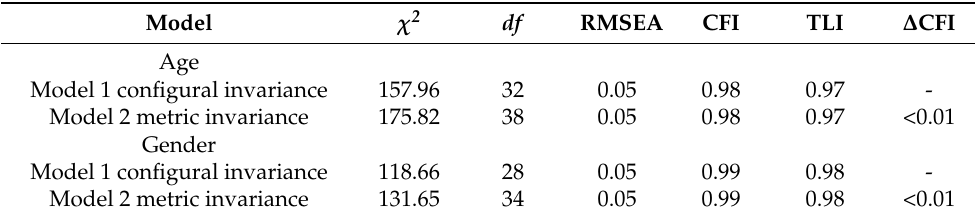
Table 4. Measurement invariance of FoMOs-C across age and gender. Model χ